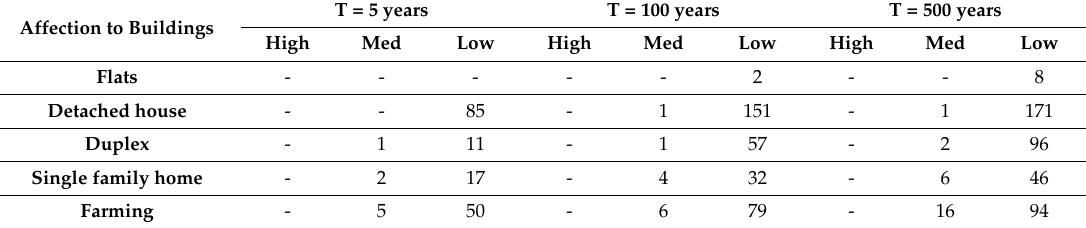
Table 7. Number of buildings of each type affected in the different